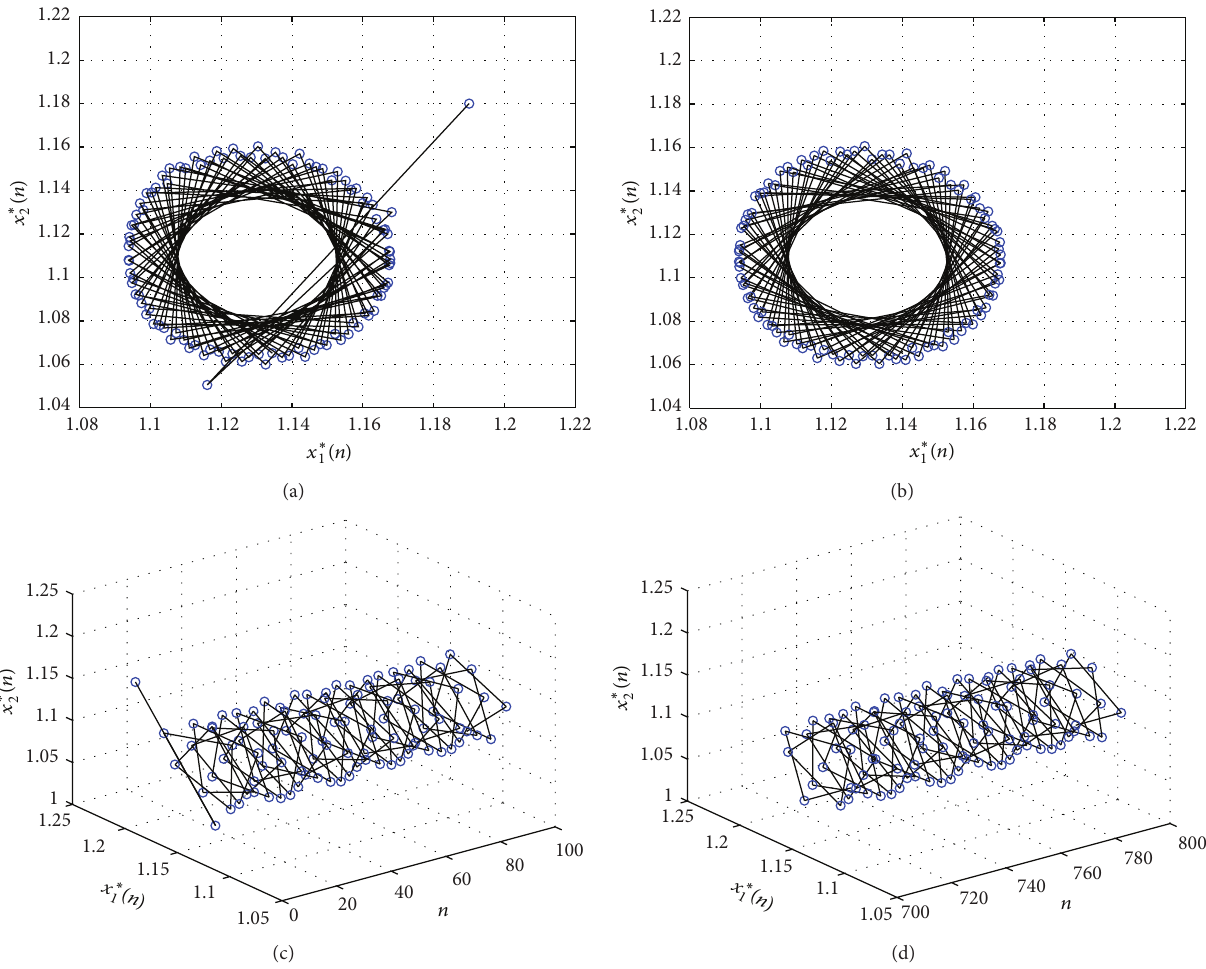
Figure 2: Phase portrait. (a), (b) 2-dimensional phase portrait of almost periodic system (13). Time-series 𝑥 ∗ 1 (𝑛) and 𝑥 ∗ 2 (𝑛) with initial values (0) = 1.19 , 𝑥 ∗ (0) = 1.18 for 𝑛 ∈ [0,100] and 𝑛 ∈ [700, 800] , respectively. (c), (d) 3-dimensional phase portrait of almost periodic system 𝑥 ∗ 1 2 (13). Time-series 𝑥 ∗ 1 (𝑛) and 𝑥 ∗ 2 (𝑛) with the above initial values for 𝑛 ∈ [0,100] and 𝑛 ∈ [700, 800] ,